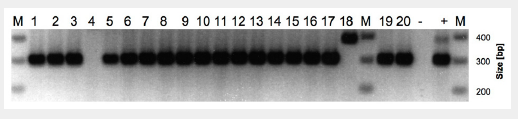
Agarose gel electrophoresis analysis of vanA and vanB PCR screening of VRE isolates. Amplicon sizes: vanA : 377 bp (lane